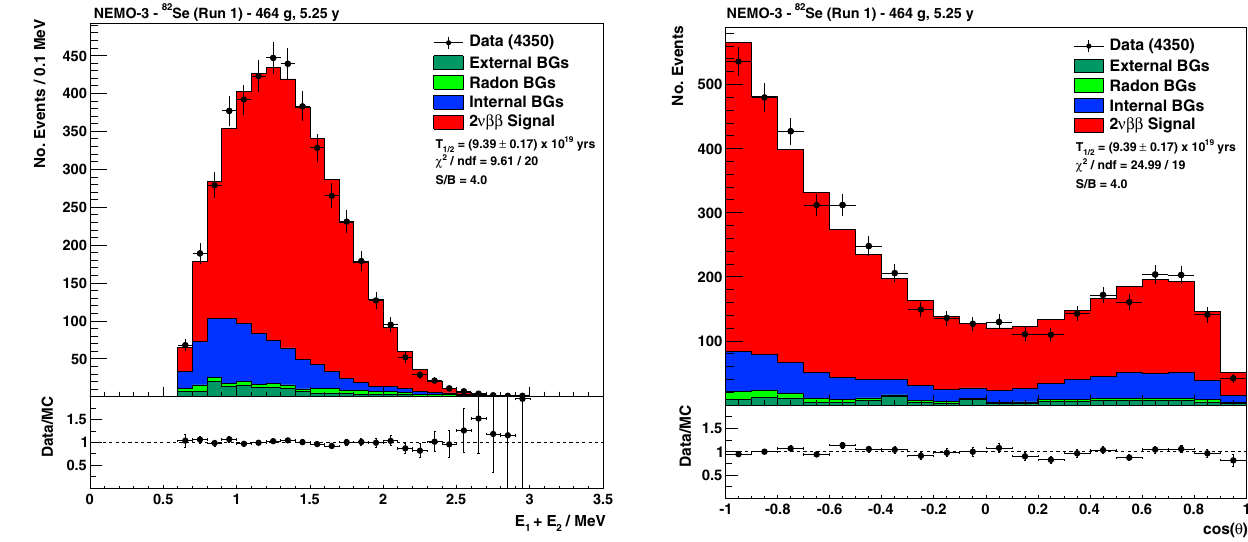
Table 3. The systematic error due to the background mod- elling is dominated by the uncertainty on the 234m Pa conver-